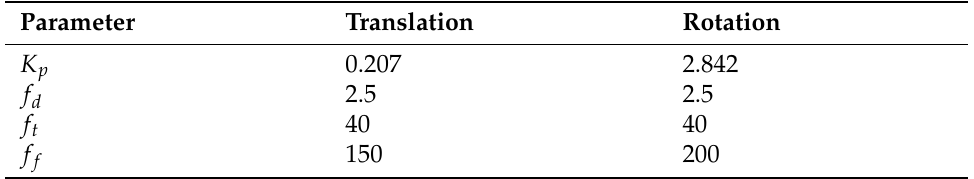
Table 4. Outer loop controller properties.